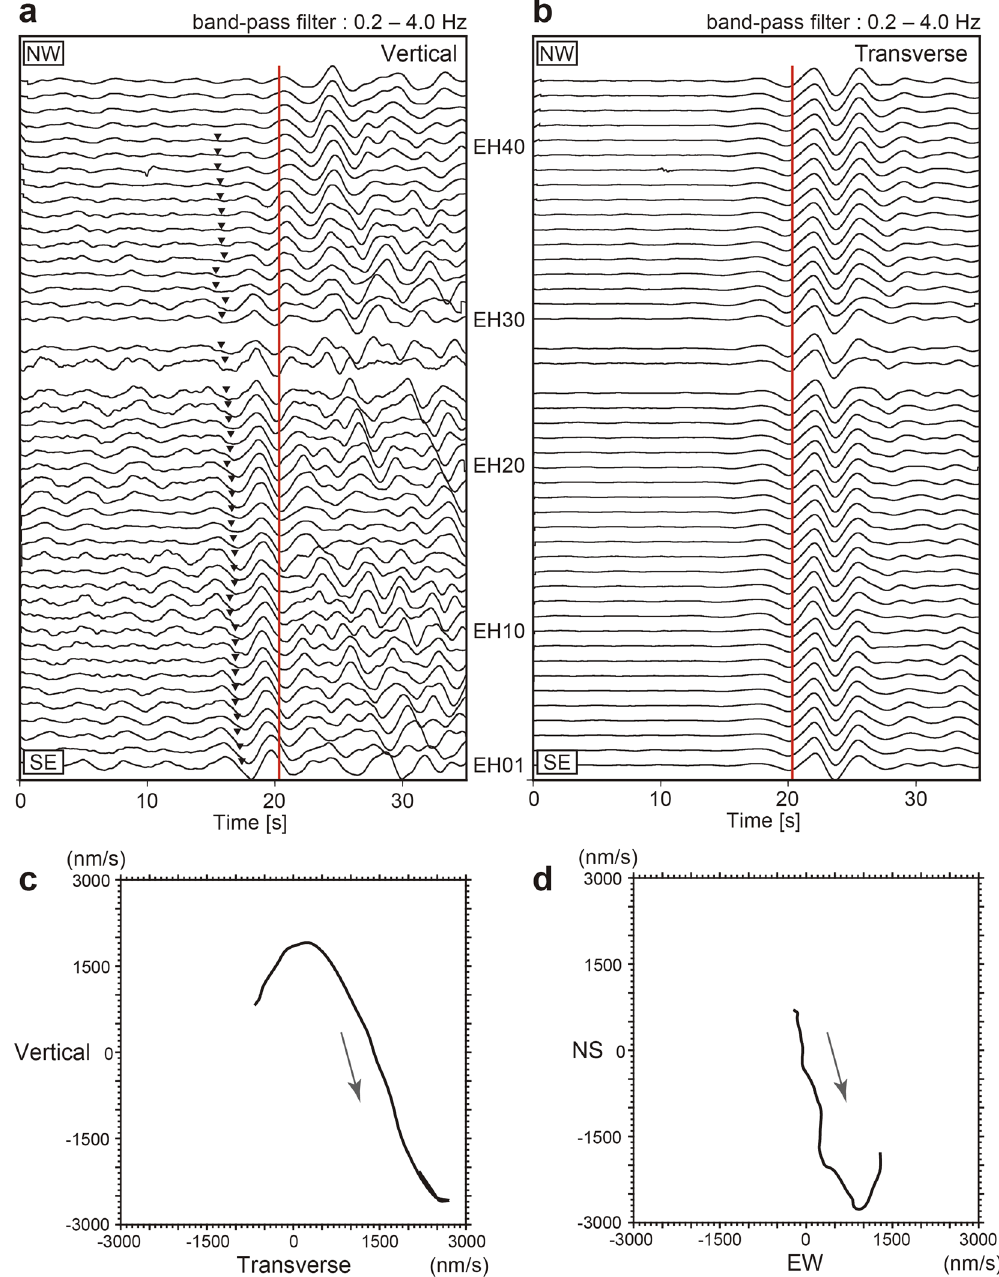
Figure 2. ( a) Vertical and ( b) transverse components of seismograms aligned around the ScS phase arrival. Red lines and black inverse triangles show onset times of ScS and ScSp phases, respectively. ( c) and ( d) show particle motions in the vertical and horizontal planes, respectively, at station